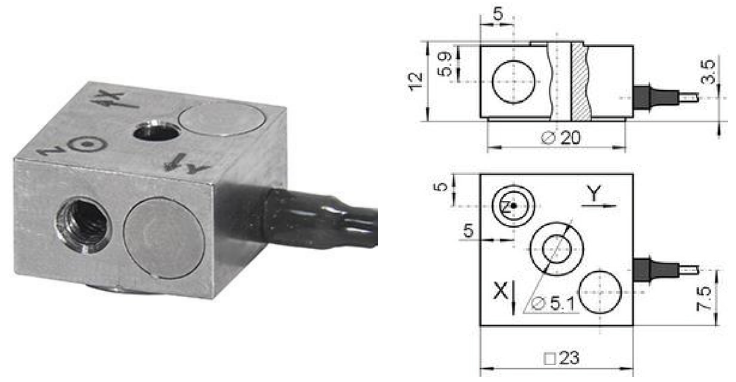
Figure 3. Appearance and dimensions of the vibration transducer АР 2038 Р .